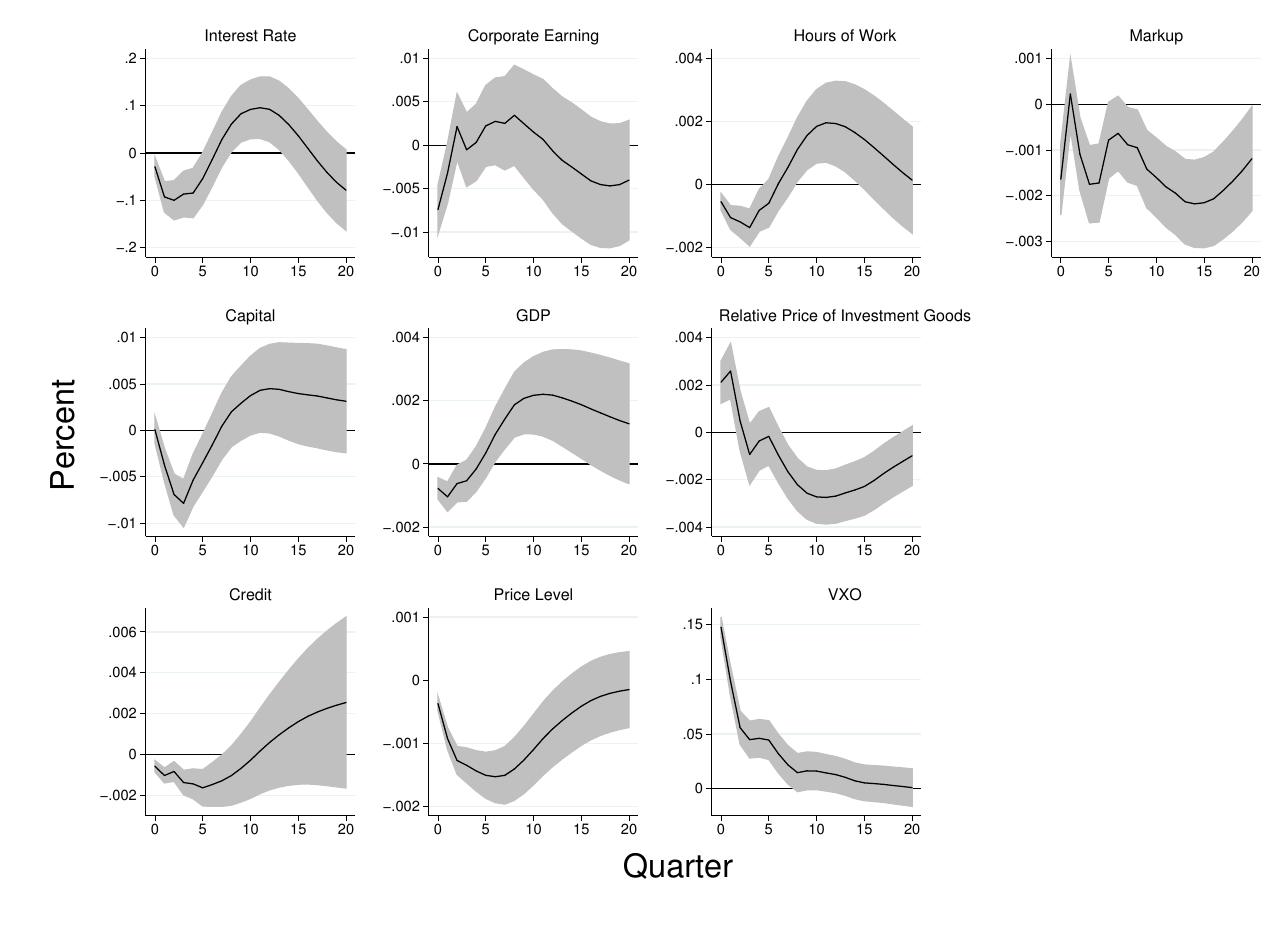
Figure A4. The Effects of Uncertainty Shocks when the Nekarda and Ramey (2021) Measure of the Price Mark-Up is Used. Notes : Shaded regions represent 90 percent standard error bands. The data are quarterly and span the period 1986Q1-2019Q4. With the exception of the federal funds rate, all the other variables are in log levels. The figure shows that both the output and markup decrease following an increase in